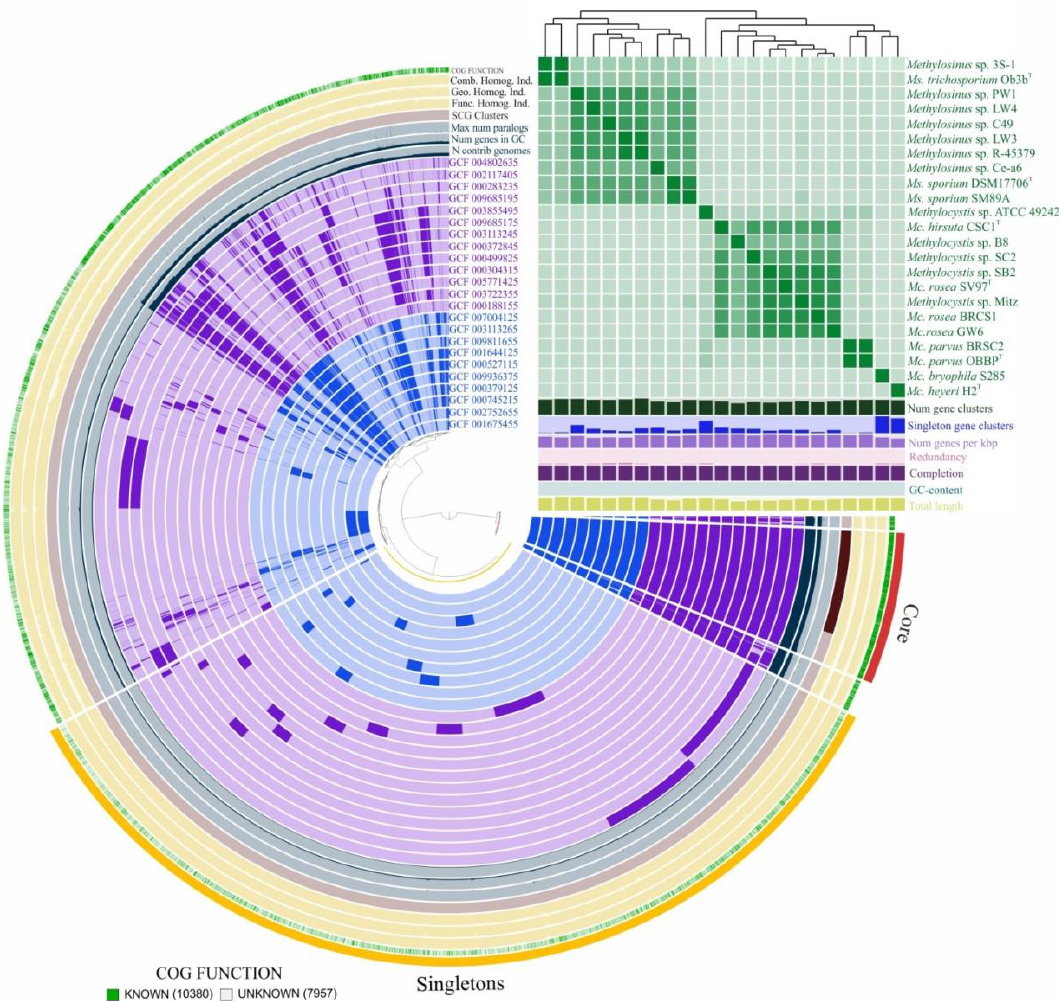
Figure 3. Pan-genome analysis. Clustering of genomes based on the presence / absence patterns of 18,322 pan-genomic clusters. The genomes are organized in radial layers as core, singleton (cloud) and accessory (shell and cloud) gene clusters [Euclidean distance; Ward linkage] which are defined by the gene tree in the center. Genomes of Methylocystis and Methylosinus species are colored by purple and blue, respectively. Line segments indicate single gene clusters. The outermost circles carry the information regarding the number of genomes containing specific gene cluster, number of genes in gene clusters, maximum number of paralogs (grey circles), distribution of single-copy gene clusters (pale pink circle), functional, geometric and combined homogeneity indexes (yellow). The layers below the heatmap display from the bottom to top: total length of the genomes, GC content, genomes completion, redundancy of each genome, number of genes per kbp, number of singleton gene clusters, total number of gene clusters. Heatmap denotes correlation between the genomes based on average nucleotide identity values calculated using pyANI [58].